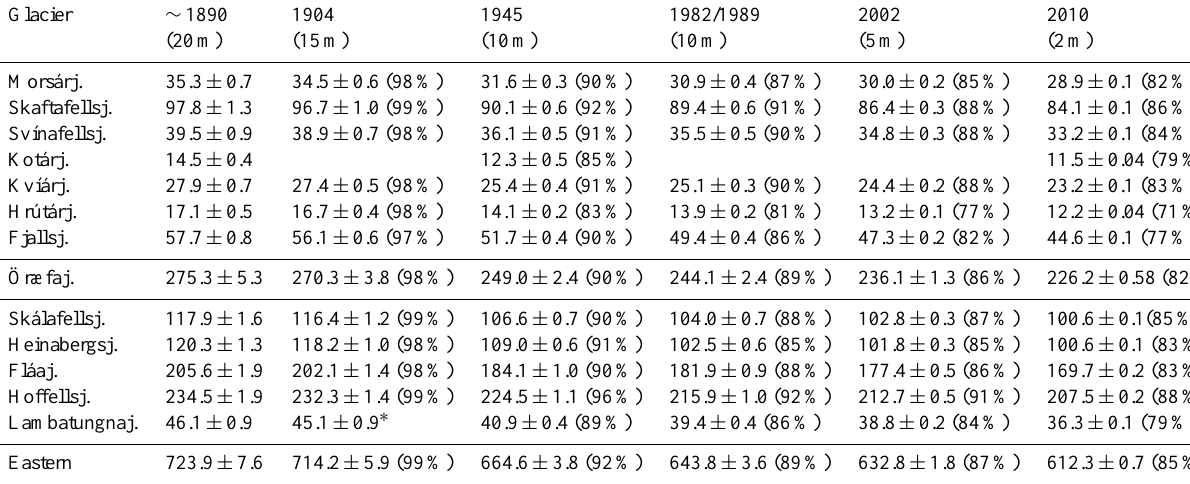
Table 3. Area of the outlet glaciers at different times in km 2 . The estimated error of the glacier margin is shown in parenthesis in the top row. The DMA aerial photographs of Öræfajökull are from 1982, and of the eastern outlet glaciers from 1989. Glacier outlines from 2002 for Öræfajökull (obtained from images of Loftmyndir ehf.), and from 2000 for Skálafellsjökull, Heinabergsjökull, Fláajökull, Hoffellsjökull and Lambatungnajökull (digitized from Landsat satellite images). Ice divides are assumed to remain constant throughout the time period. The numbers for Hoffellsjökull are from Aðalgeirsdóttir et al. (2011). Percentages are relative to the ∼ 1890 area. ∗ The area of Lambatungnajökull in 1904 is estimated from the relative extent of the neighbouring outlets in that year (99%). Kotárjökull is not included in the sum of the Öræfajökull outlets, since its area is only known for ∼ 1890 and 2010. Glacier ∼ 1890